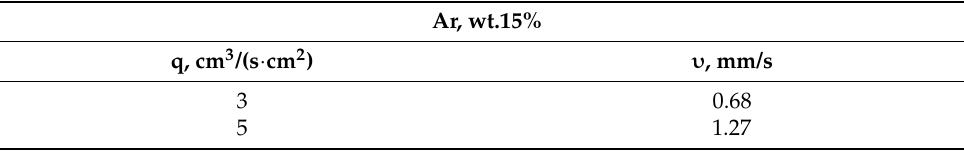
Table 3. Combustion rate of the (70% AlN+ 30% Al) sample.